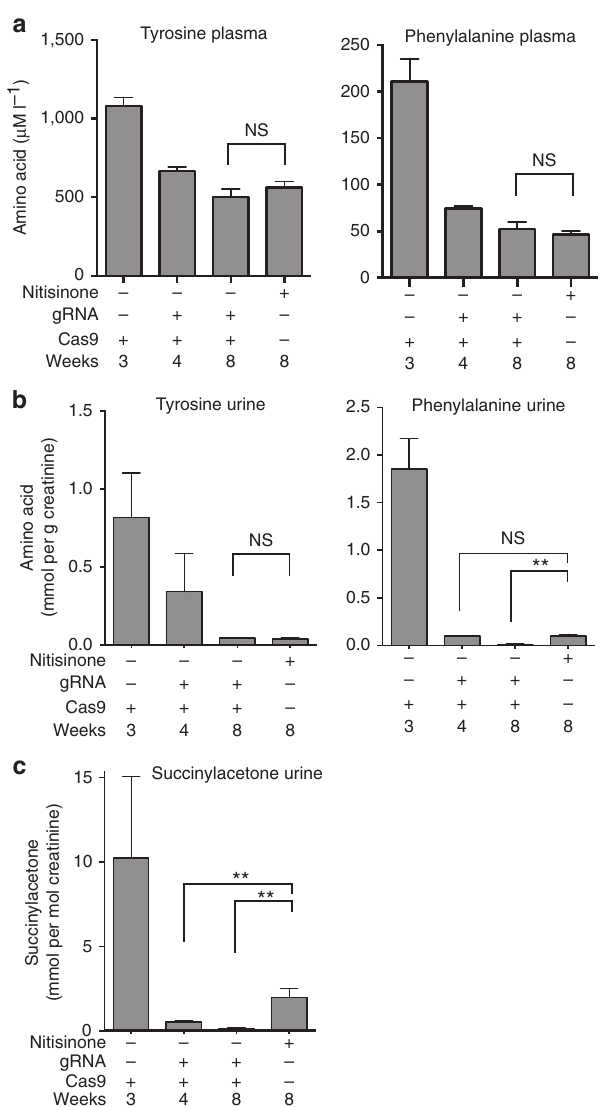
Figure 3 | Metabolic profile of tyrosinemic mice treated with nitisinone or metabolic reprogramming. ( a ) Tyrosine and phenylalanine levels in the plasma of mice treated with either nitisinone or CRISPR/Cas9, 4 and 8 weeks after therapy. Untreated mice were used as controls. Tyrosine, phenylalanine ( b ) and succinylacetone ( c ) in the urine compartment of the same mice as in a . t -tests were used to determine statistical significance. Bars represent mean ± s.e.m., group size ( N ¼ 3–5) mostly dependent on urine